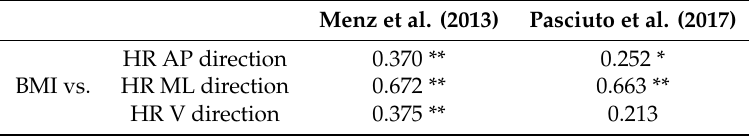
Table 3. Spearman’s rho correlation coe ffi cients between BMI and HR values. Menz et al.